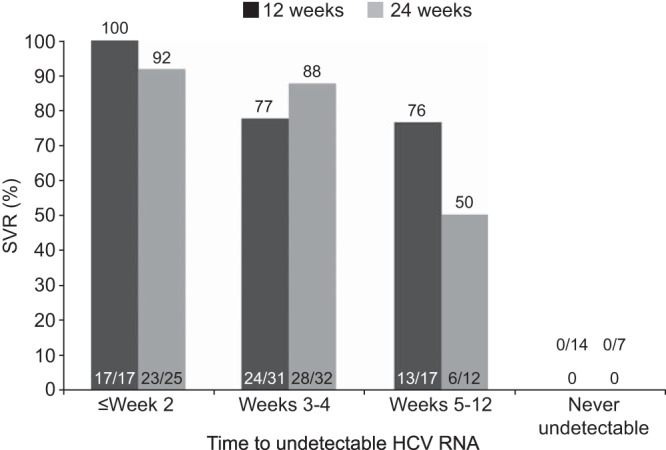
Sustained virologic response (SVR) rates in relation to time taken to achieve undetectable HCV RNA. A shorter time to achieve undetectable HCV RNA was associated with higher likelihood of SVR.